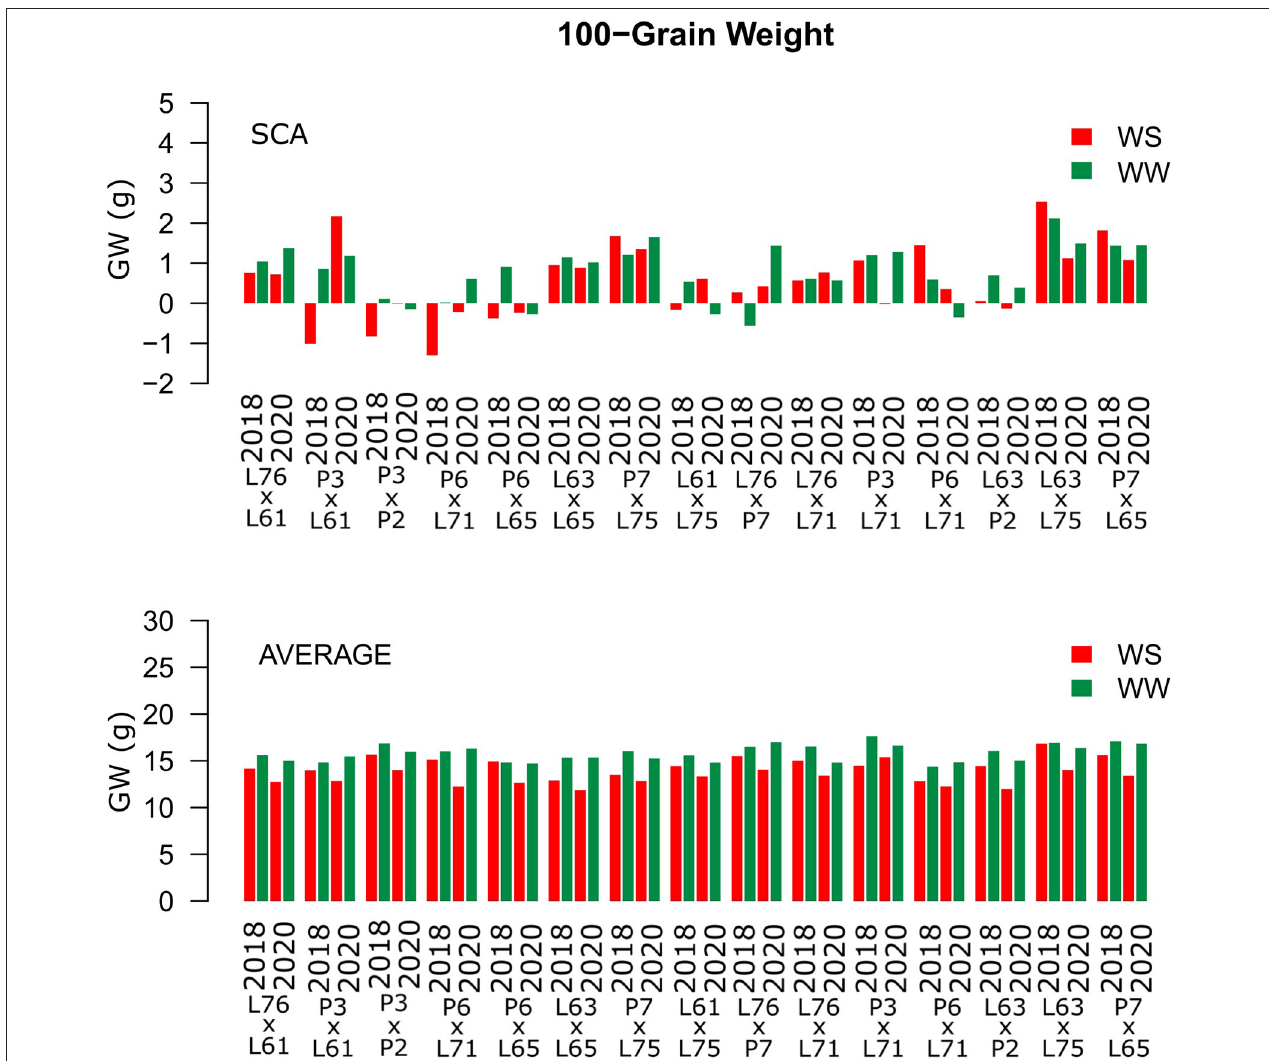
FIGURE 8 | Estimation of the SCA and 100-GW (g) mean values for popcorn hybrids evaluated under two WCs and crop seasons in 2018 and 2020. WS is represented by red bars and the WW condition is represented by dark-green